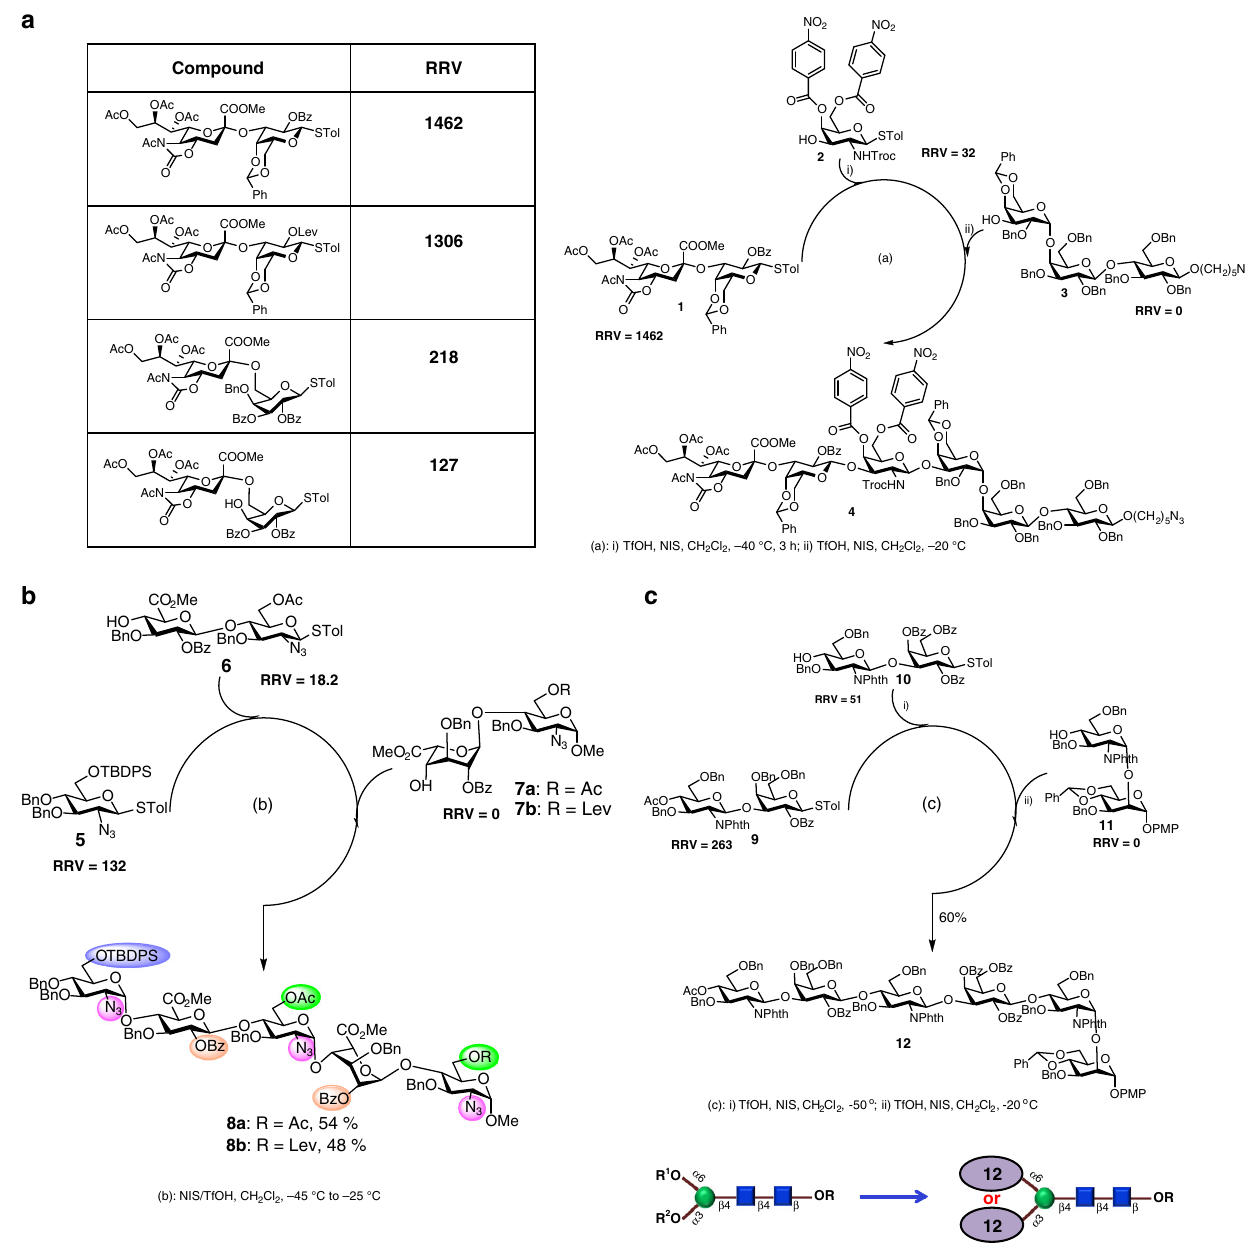
Fig. 3 Examples of programmable one-pot synthesis. a Auto-CHO suggests that SSEA-4 can be synthesized with three BBLs: sialyl disaccharide 1 with RRV = 1462, monosaccharide 2 with RRV = 32.0, and reducing end acceptor 3 with RRV = 0. The calculated overall yield is 94% and the experimental yield is 43%. b Synthesis of a heparin pentasaccharide with differential protecting groups in color to allow selective introduction of the sulfate groups. c Synthesis of the oligoLacNAc module for the assembly of N -glycans with LacNAc